Question: Give a one-sentence summary of this figure.
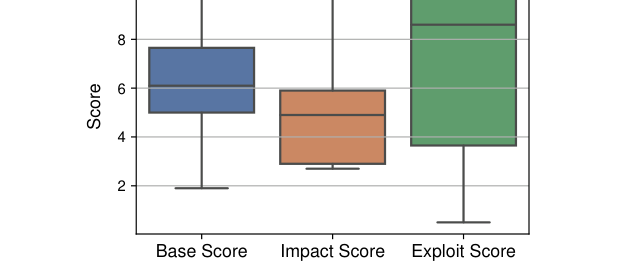
Answer: Distribution of Vulnerability Scores